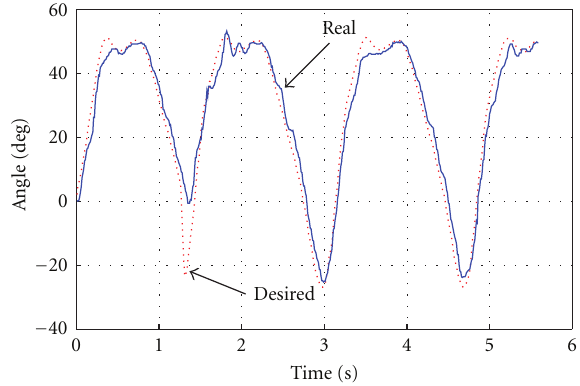
Figure 13: Real and desired hip joint angle of artificial leg during swing.